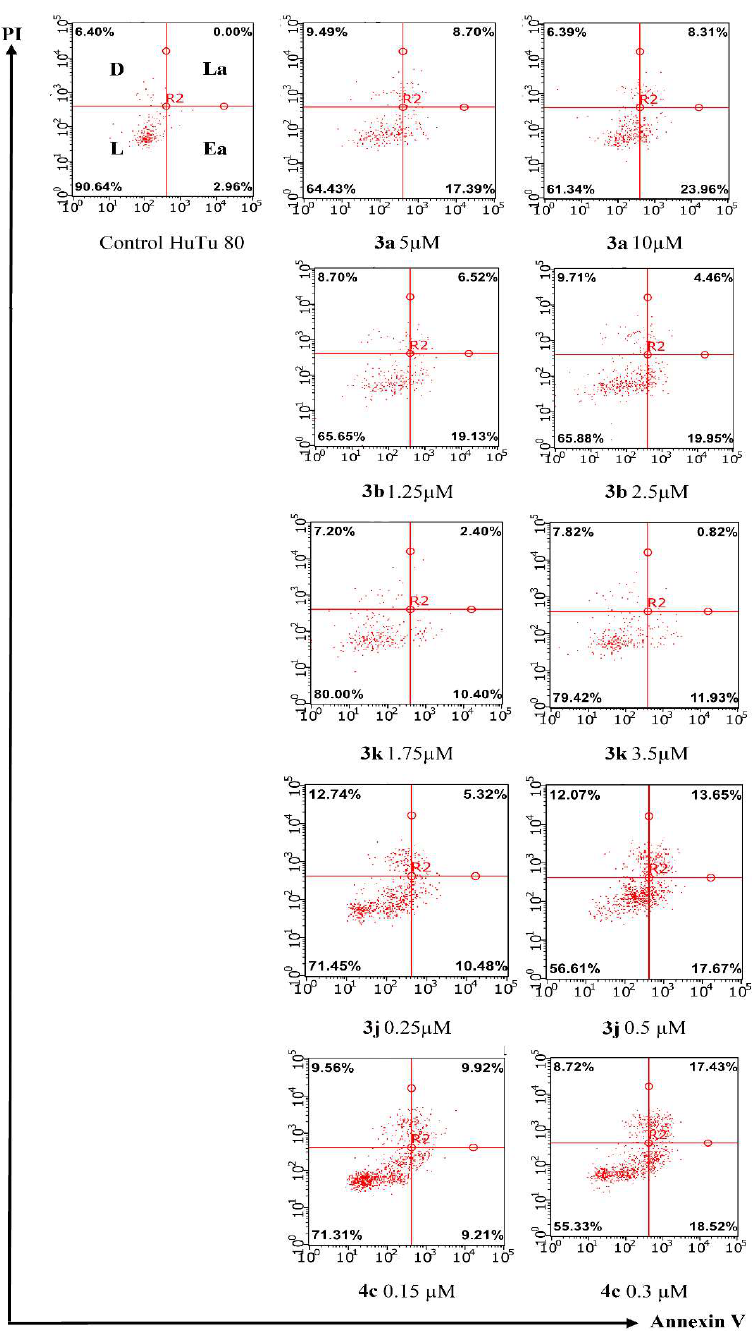
Figure 4. Induction of apoptosis in HuTu-80 cells incubated with compounds 3a , b , k , j and 4c at a concentration of IC 50 /2 and IC 50 in µ M for 48 h. L—living cells; D—dead cells; Ea—early apoptotic cells; La—late apoptotic cells.